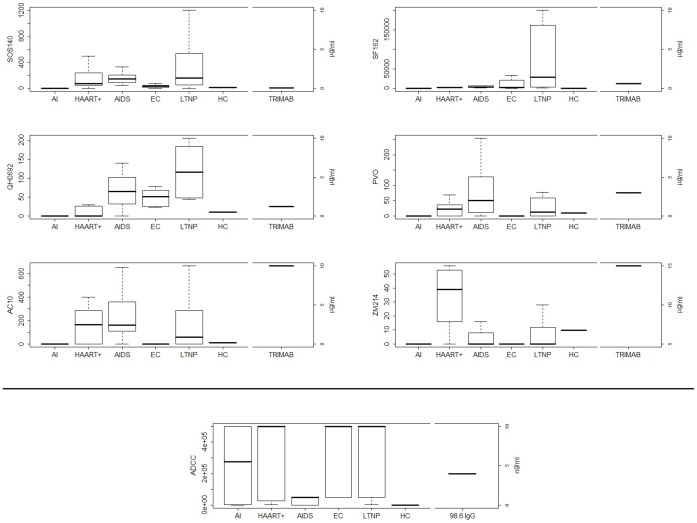
Antibodies functional activities including neutralization and ADCC in the study population.Neutralization profiles obtained with six different viruses in two assays which use U87 or TZM.bl cell lines as target cells are shown. SOS140 was used to infect U87 cell line, the other viruses including SF162 (lab strain), three clade B (QH0692, PVO and AC10) and a clade C (ZM214) viruses were used to infect TZM.bl. HC (healthy controls) pooled sera were used as negative control and TRIMAB monoclonal antibody mix was used as positive control. The values are expressed as IC50 (serum dilution 1/n for all samples or µg/mL for TRIMAB leading 50% of infectivity reduction). The last panel, in the middle, shows ADCC activity by all five groups of HIV seropositive subjects. HC (healthy controls) pooled sera and 89.6 IgG were used as negative and positive controls, respectively. The values are expressed as titers.